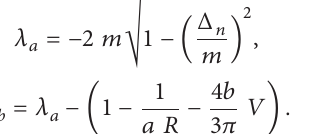
= 0 , (𝑉,𝜃) = (3.9 V ,0 ∘ ) is a stable node with 𝜆 𝑛